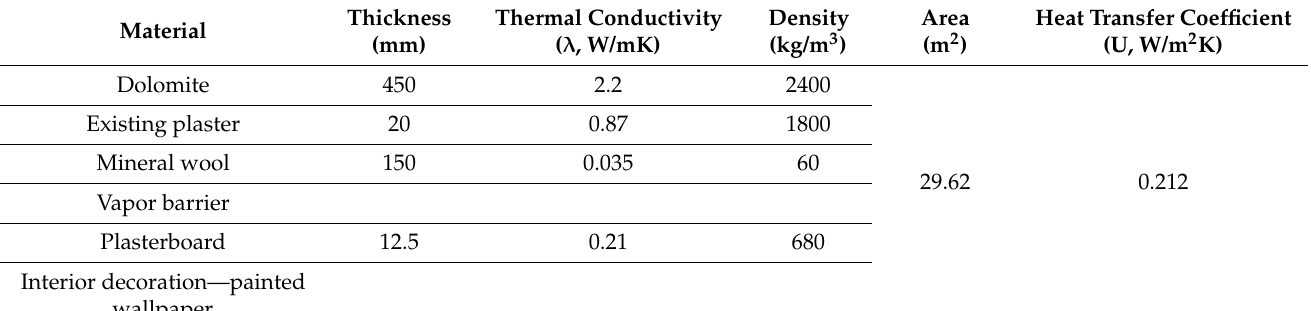
Table 3. Facade construction after retrofit in 2015: Type 3.